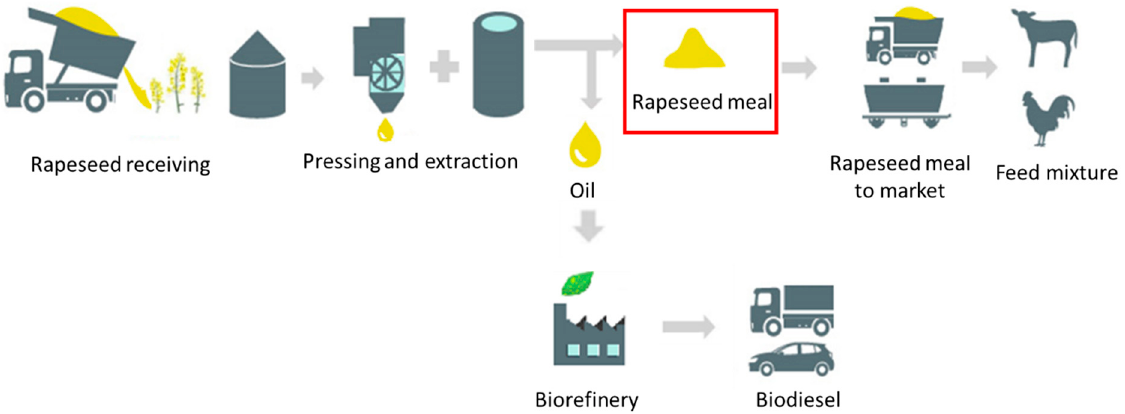
Figure 4. Scheme of rapeseed meal production and processing and its connection to feed market and biofuel biorefineries.